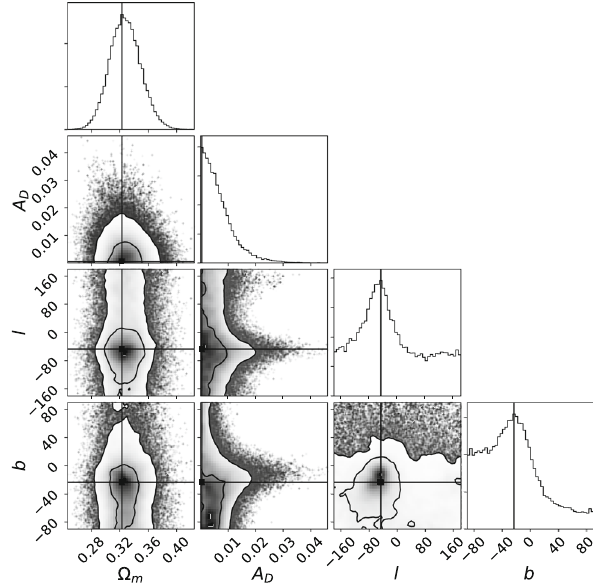
Fig. 6 The marginalized posterior distribution of the parameters in the Finslerian cosmological model with the 2020 quasar compilation. The horizontal and vertical solid black lines denote the maximum of 1-dimensional marginalized posteriors